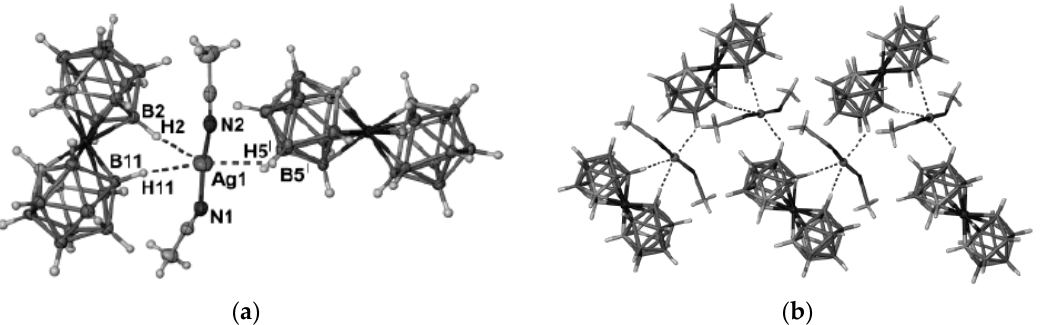
Figure 102. X-ray structure of {((MeCN) 2 Ag)[3,3’-Co(1,2-C 2 B 9 H 11 ) 2 ]} n : coordination arrangement of silver cation ( a ) and crystal packing ( b ). Reprinted with permission from reference [122]. Copyright © (2003) American Chemical Society.